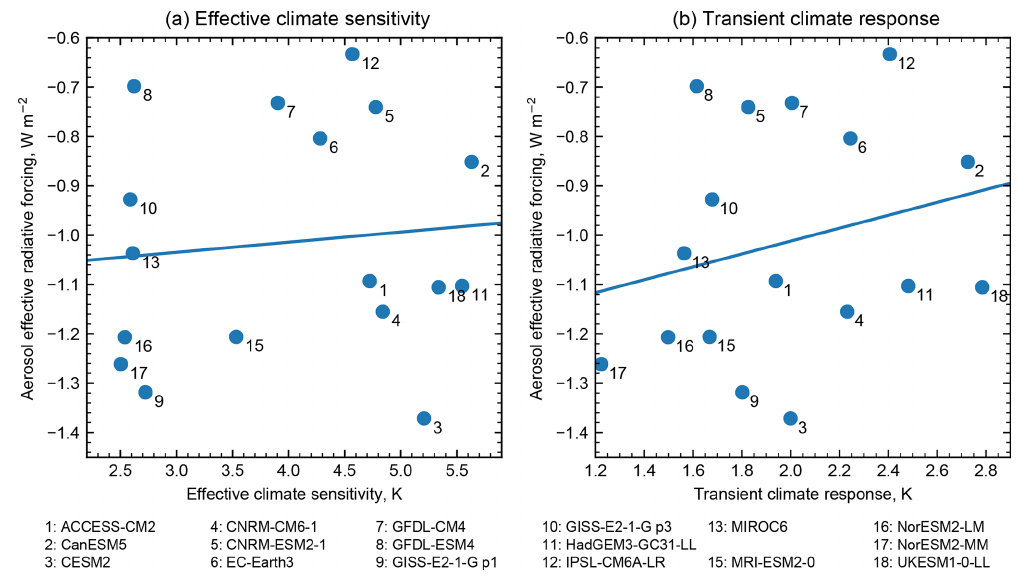
Figure 9. Relationship between (a) ECS and (b) TCR and aerosol ERF in the CMIP6 model ensemble. MPI-ESM1.2-LR (model 14) did not produce the piClim-aer